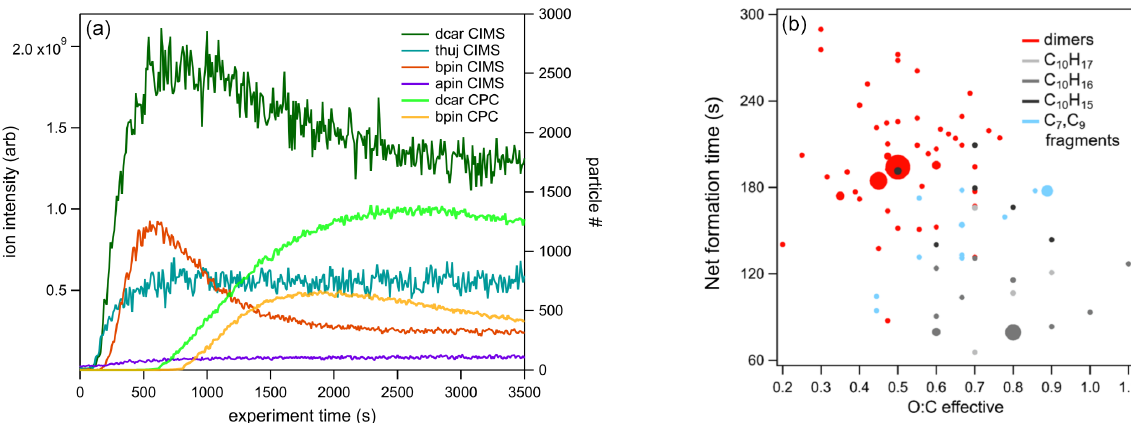
− CIMS and plotted with the associated 3